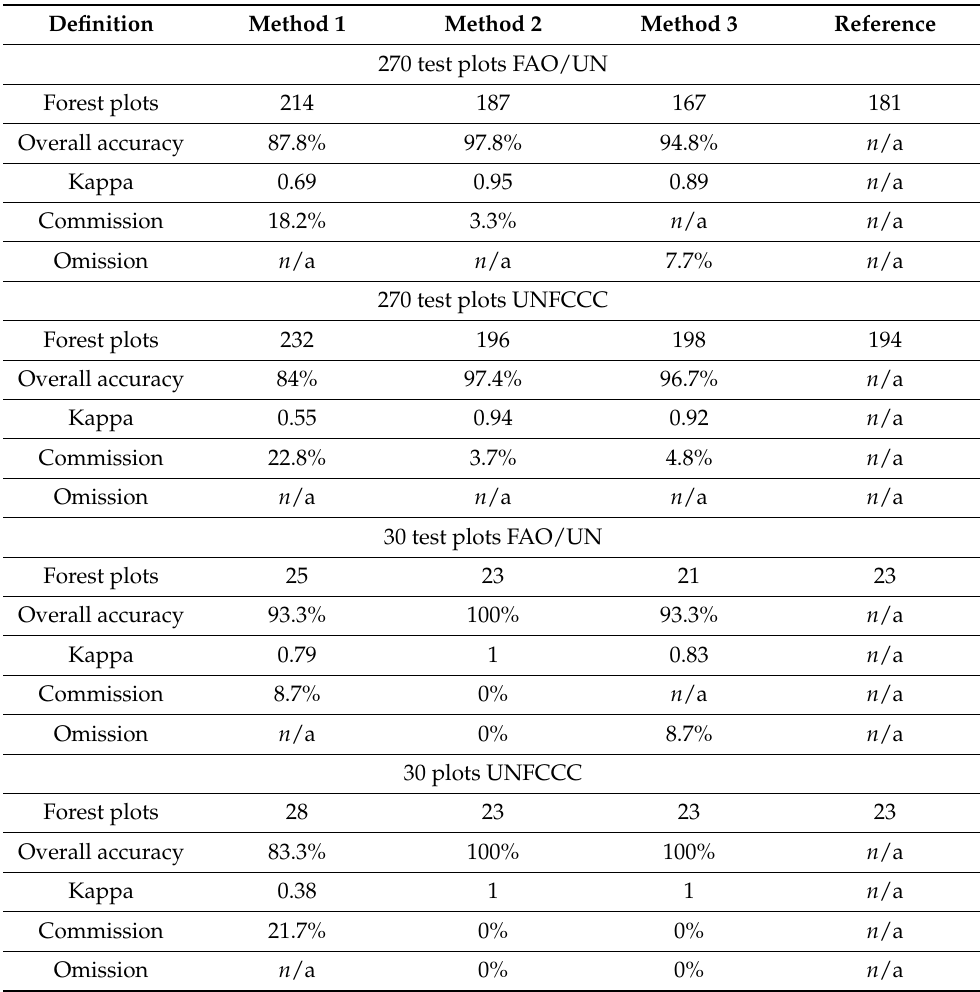
Table 5. The number of test plots (10 × 10 m 2 and 30 × 30 m 2 ) with the forest vegetation of ≥ 10% according to particular methods and